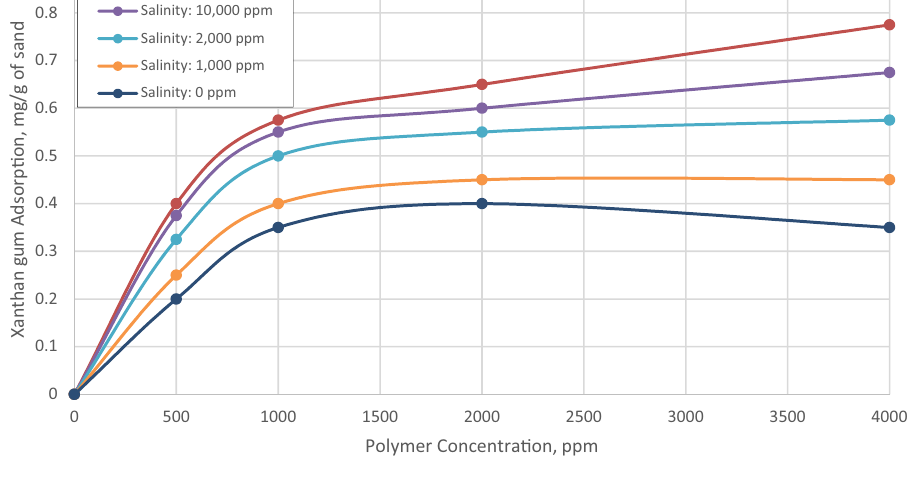
Fig. 5 Typical plots used to calculate the Langmuir isotherm model parameters for refined xanthan